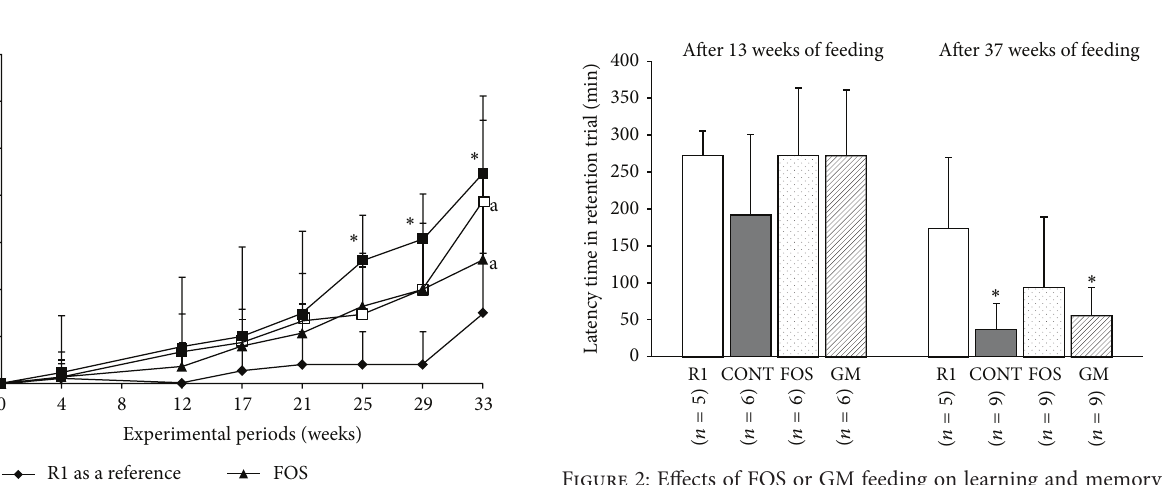
Figure 2: Effects of FOS or GM feeding on learning and memory performance in SAMP8 after 13 weeks and 37 weeks of feeding. R1, SAMR1, and control diet; CONT, control diet; FOS, 5% of fruc- tooligosaccharide diet; GM, 5% of glucomannan diet. ∗ Significant differences versus SAMR1, respectively, at 𝑃 < 0.05 by ANOVA and Tukey’s post hoc